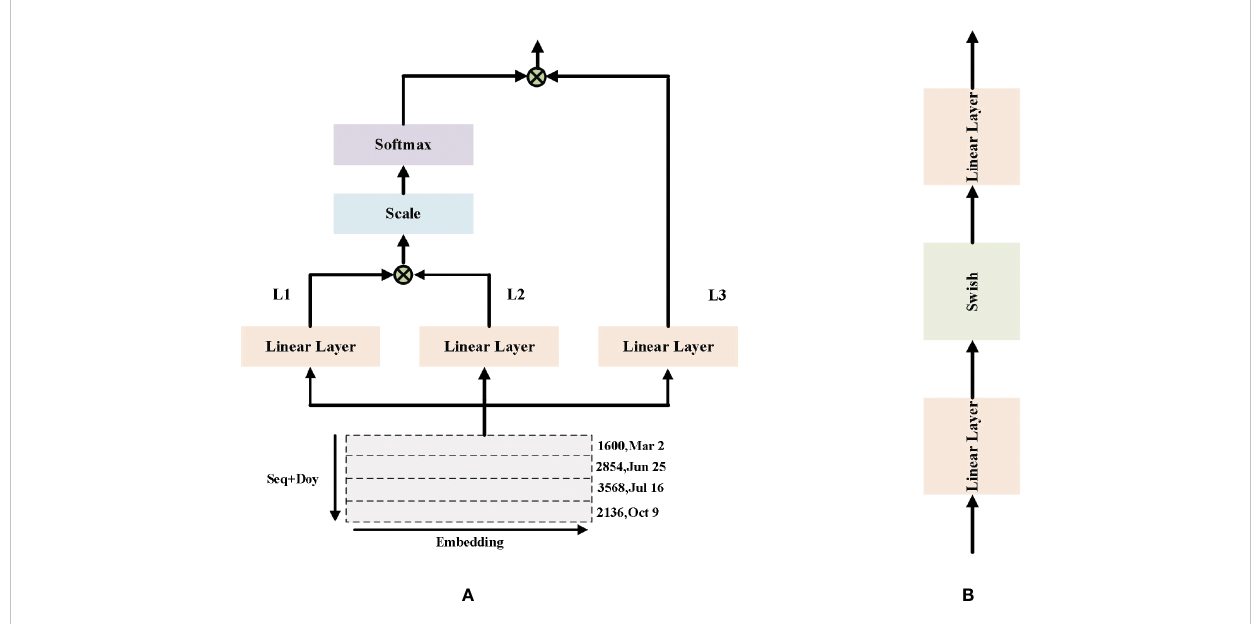
where L j represents j -th Linear Layer in MHAL; d represents the feature vector of dimension; x i denotes model input, and ^ x i denotes MHAL output. Softmax is used to calculate the score of each